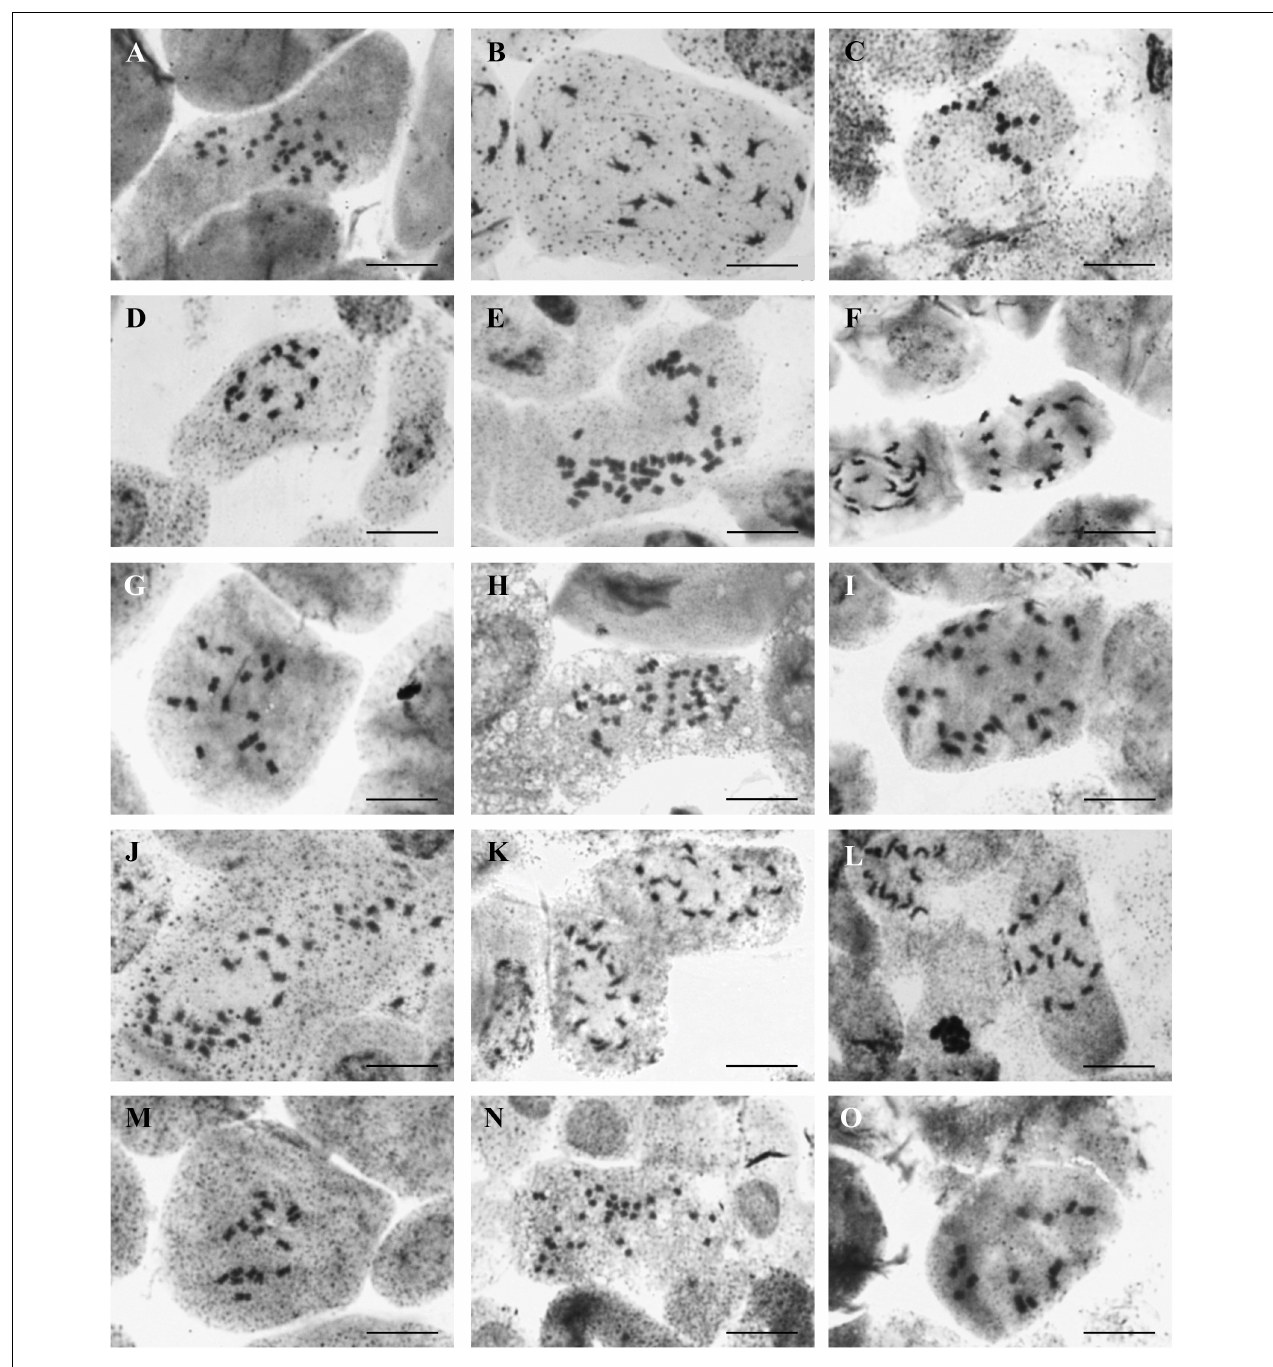
FIGURE 2 | Photographs of chromosome metaphase plates from (A) Alyssum alyssoides (427AMB- al ), 2 n = 32; (B) Alyssum foliosum (151KAT- fo ), 2 n = 16; (C) Alyssum fulvescens (594PEO- fu ), 2 n = 16; (D) A. fulvescens (595KEK- fu ), 2 n = 16; (E) Alyssum hirsutum (506DRK- hi ), 2 n = 48; (F) Alyssum minutum (319LOM- mi ), 2 n = 16; (G) Alyssum simplex (551RBS- sx ), 2 n = 16; (H) Alyssum siculum (549QUA- sc ), 2 n = 48; (I) Alyssum collinum (261UXA- cl ), 2 n = 32; (J) Alyssum simulans (481PTK- ss ), 2 n = 32; (K) Alyssum smyrnaeum (544DTI- sy ), 2 n = 16; (L) Alyssum strigosum (457SVU- st ), 2 n = 16; (M) A. strigosum (477VAD- st ), 2 n = 16; (N) Alyssum turkestanicum (429ORT- t ), 2 n = 32; and (O) Alyssum umbellatum (458PSS- um ), 2 n = 14. Scale bar = 10 µ m.